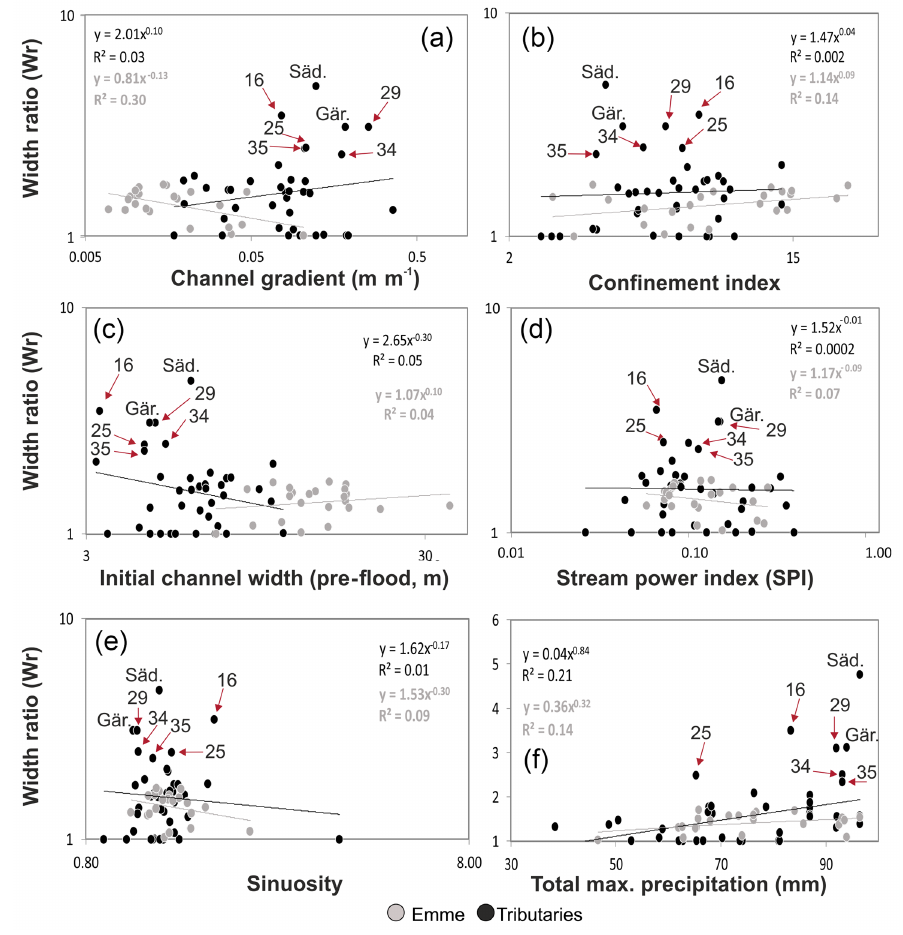
Figure 4. Relationships between width ratio and (a) channel gradient; (b) confinement; (c) channel width (pre-flood); (d) stream power index (in mm − 1 km − 2 ); (e) sinuosity; (f) total maximum precipitation. Grey dots show sub-reaches along the Emme River, and black dots show sub-reaches along tributaries. Sub-reaches with the largest values are labeled. Säd.: Sädelgrabe; Gär.: Gärtelbach; numbers are sub-reaches as shown in Table 1. Grey and black lines show regression lines for the Emme River sub-reaches and tributary sub-reaches, respectively. Note that panel (f) has a linear x axis in contrast to the logarithmic x axis of panels (a) – (e)